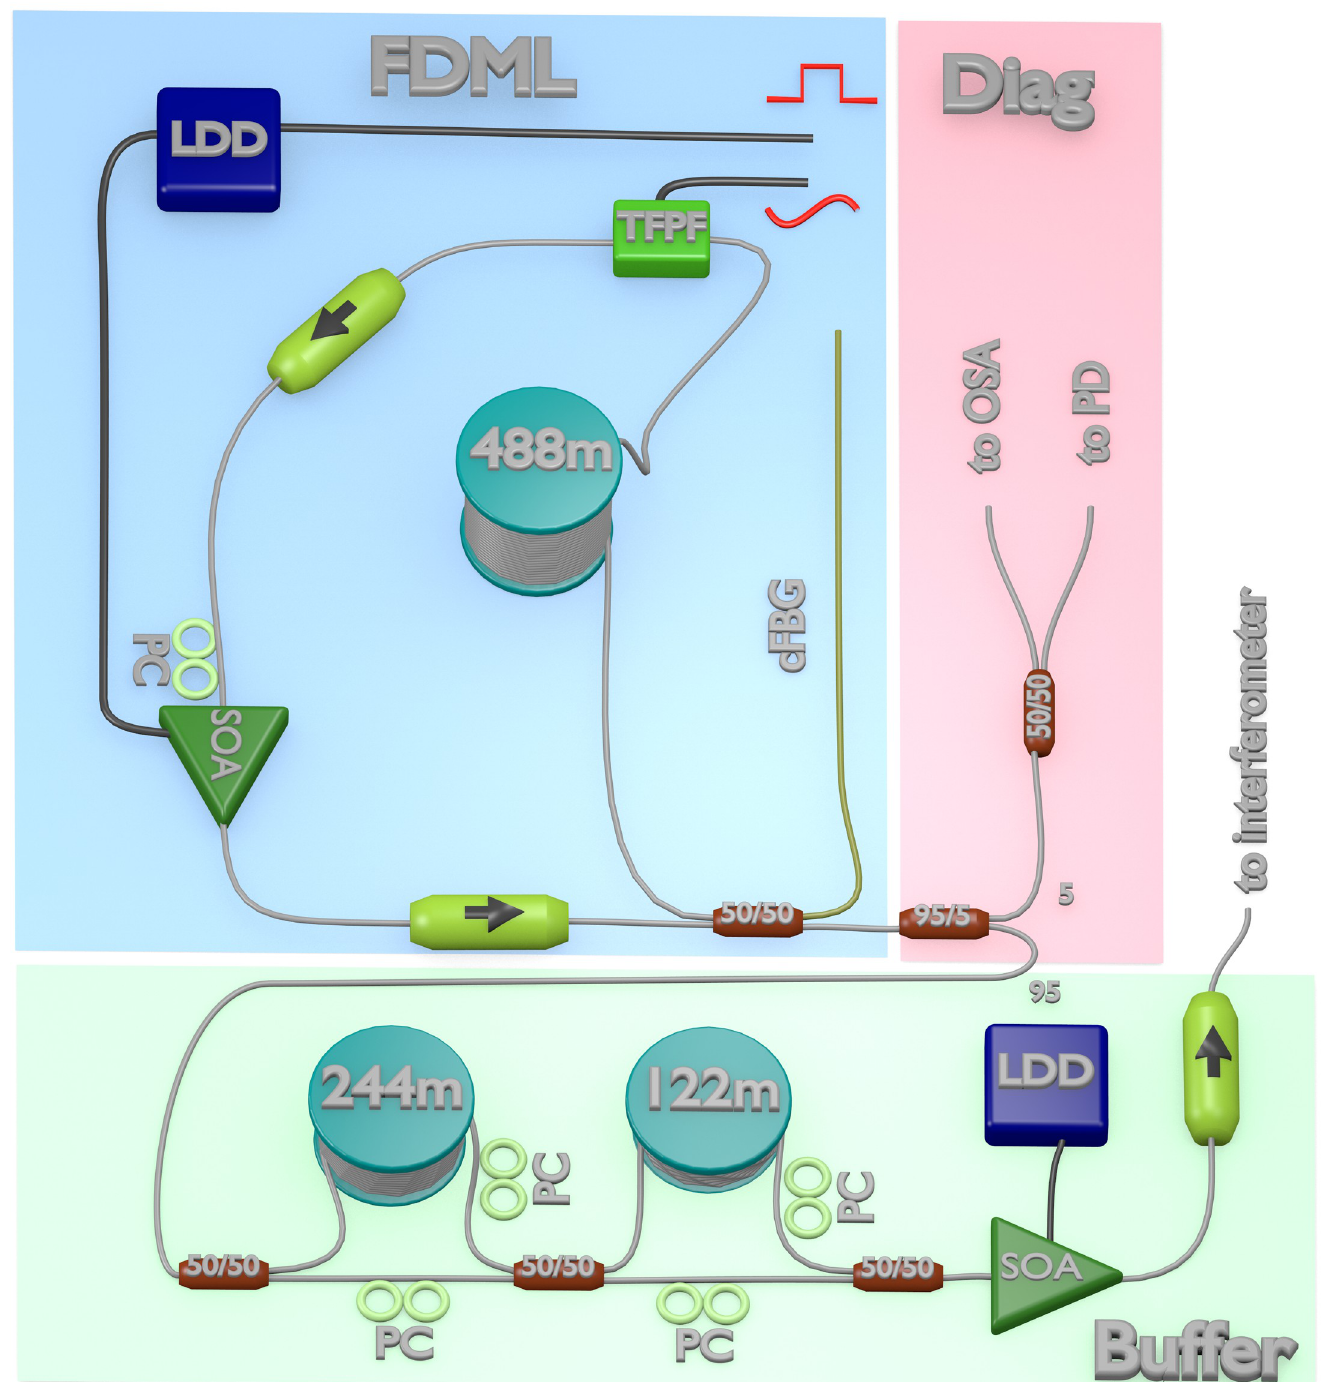
Fig 1. Schematic of the FDML laser with a 4x buffer stage (1.67 MHz) used in the experiments. The 3.34 MHz version has an additional fiber spool and coupler in the buffer stage. LDD: laser diode driver, TFPF: home build tunable Fabry-Pe´rot filter, PC: polarization controller, arrow: optical isolator, SOA: semiconductor optical amplifier, cFBG: chirped fiber Bragg grating, OSA: optical spectrum analyzer, PD: photodiode. Numbers on spools show fiber length. The LDD in the laser cavity receives a rectangular signal, the TFPF a sinusoidal. Buffer: buffer stage; Diag: laser diagnostics.